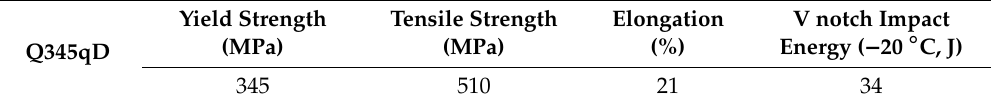
Table 2. Welding Table 2. Welding procedure. Table 2. Welding procedure.